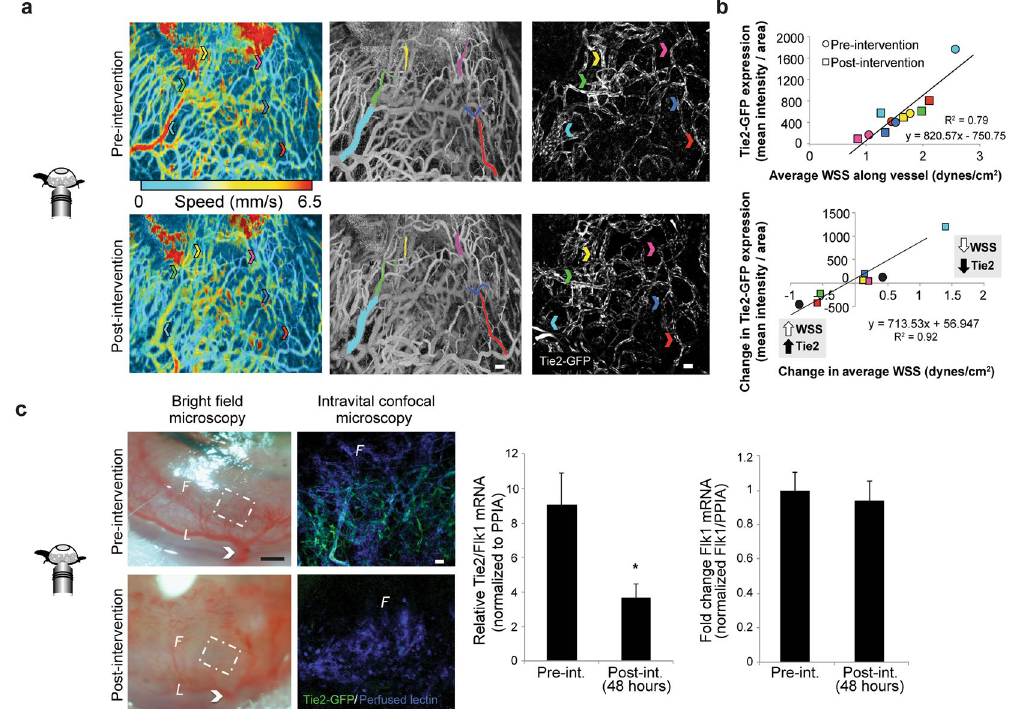
Figure 3. Representative example murine cornea analyzed using the dual imaging method demonstrates that endothelial cell Tie2-GFP fluorescence intensity was directly correlated with blood flow-induced WSS. ( a ) Changes in average WSS were correlated with changes in Tie2-GFP fluorescence intensity. Arrows indicate the color-matched vessel segments between PAM (center) and ICM (right). ( b ) The top graph shows the quantification of Tie2-GFP fluorescence intensity (mean intensity/pixel 2 ) obtained using ICM versus blood flow-induced WSS (dynes per cm 2 ) obtained using PAM. Measurements obtained pre-intervention are plotted as circles, measurements obtained post-intervention are plotted as squares, and each vessel segment that was analyzed is represented by the color that corresponds to the vessel segment highlighted in ( a ). The bottom graph reports the change in Tie2-GFP fluorescence intensity obtained using ICM versus the change in WSS obtained using PAM (both measurements are pre-ligated minus post-ligated values). ( c ) Bright field images of a representative cornea pre-intervention (top left) and 48 hours post-intervention (bottom left) show that blood flow is decreased throughout the network following an extensive surgical intervention. Right panel shows ICM images of the magnified vascular networks that are outlined by the white, dashed line boxes in the bright field images to the left, both pre- and 48 hours post-intervention. White arrow indicates the location of an arteriole branching off the limbus that was cauterized. Tie2 mRNA normalized to Flk1 + mRNA (left graph, n = 5 mice, p < 0.01) demonstrates a significant decrease in corneal Tie2 gene expression 48 hours after network-wide decrease in blood flow. In the same corneas, however, endothelial cell Flk1 mRNA (right graph, n = 5, p = 0.4) was unchanged. White scale bar indicates ( a , c ) 50 µ m. Black scale bar indicates ( c ) 500 µ m.